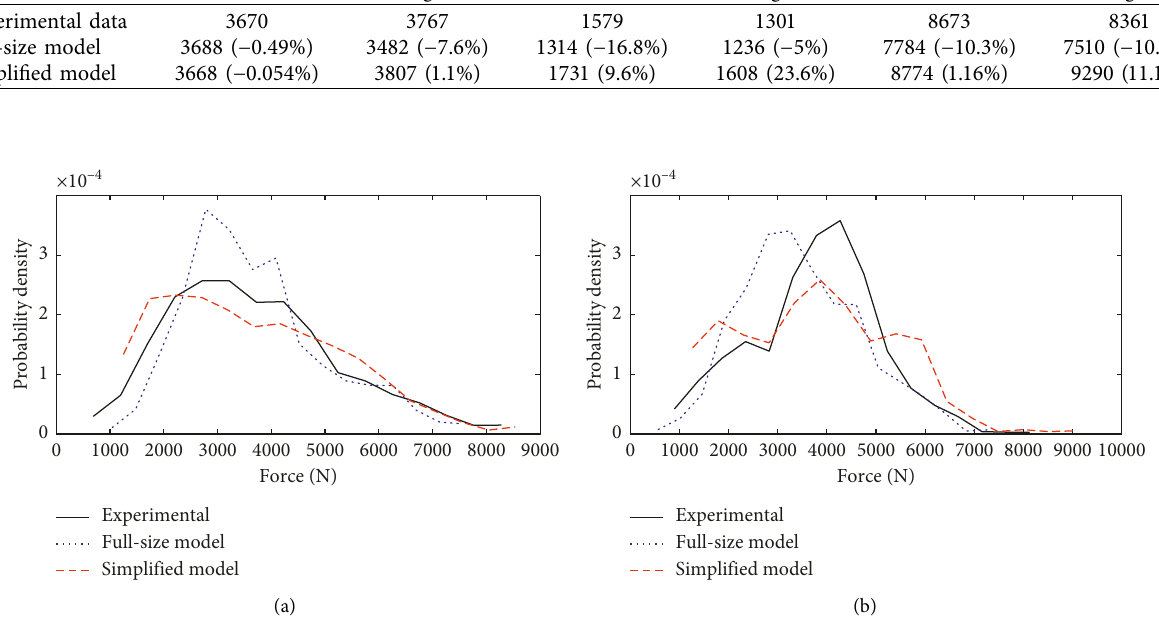
Figure 7: Probability density distribution: vertical force of (a) left wheel; (b) right wheel.